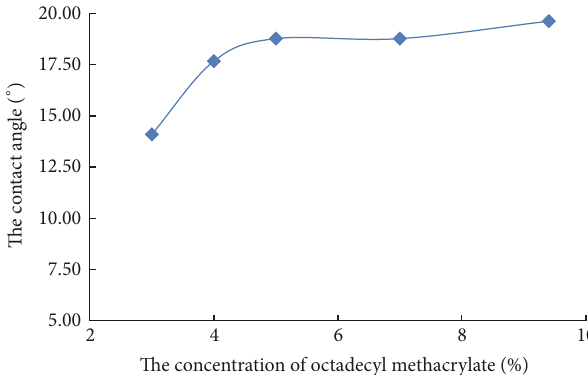
Figure 7: The contact angle of octadecyl methacrylate-acrylamide- N,N 󸀠 -bis(acryloyl)-cystamine hydrogel.